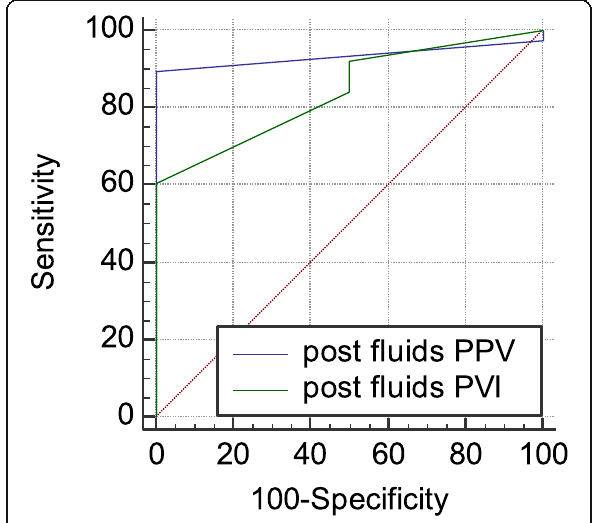
Fig. 5 Correlation between ROC of PPV and PVI after fluid bolus. The correlation between two ROC of PPV and PVI after 5 ml/kg fluid bolus during periods of hypovolemia in liver